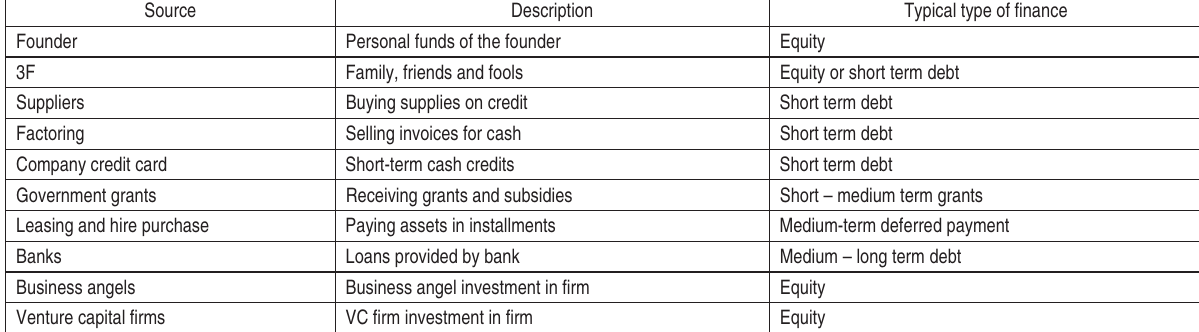
Table 1. Sources of finance for entrepreneurial